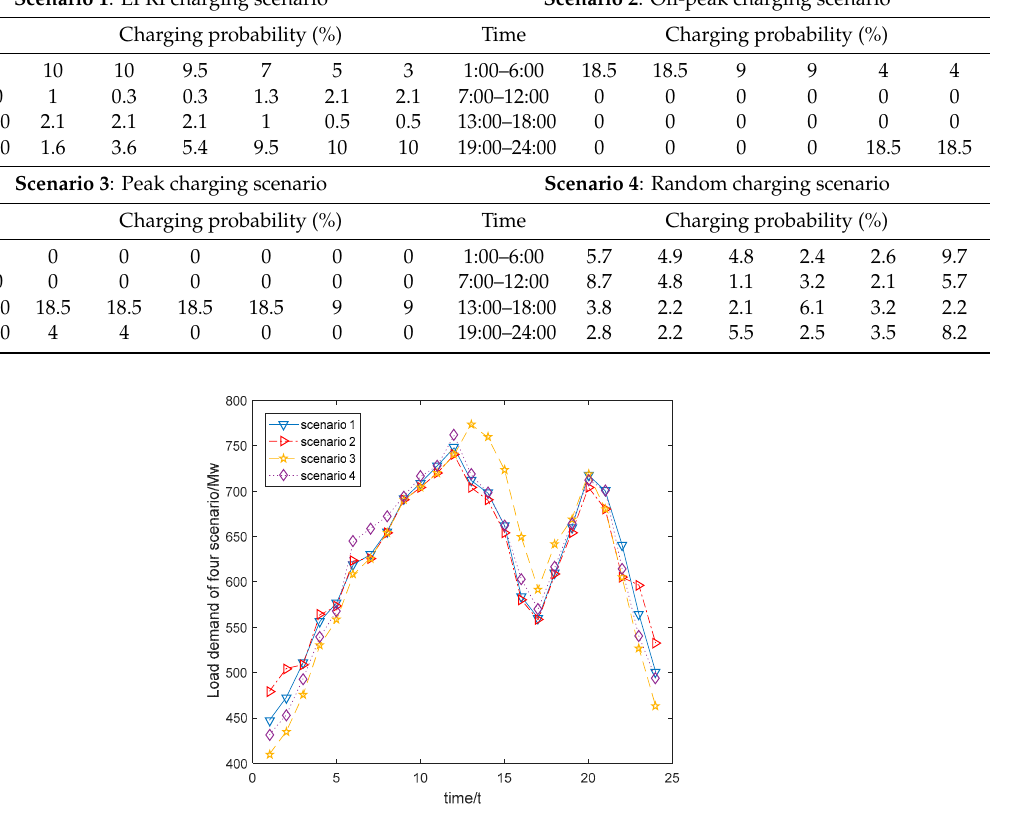
Table 3. Four charging scenarios.